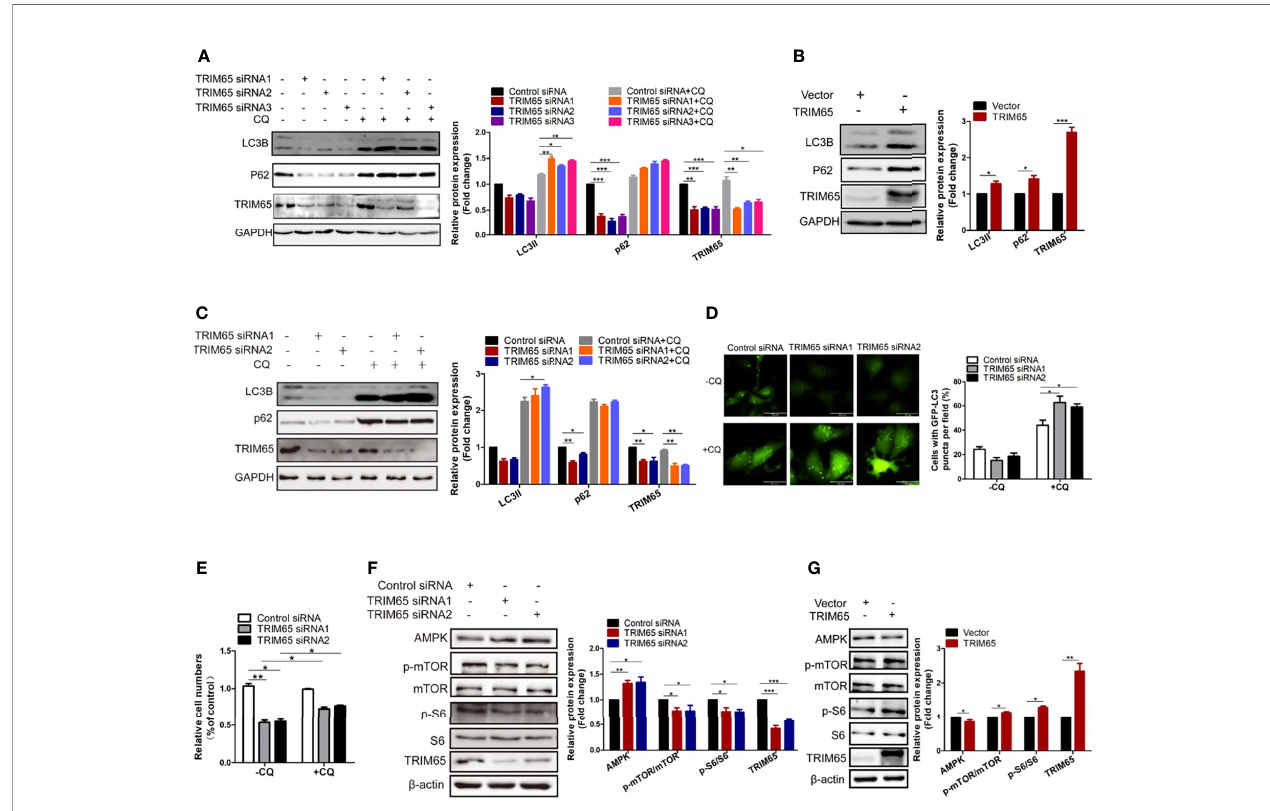
FIGURE 3 | Knocking down TRIM65 induces autophagy in cervical cancer. HeLa (A) and SiHa (C) cells with TRIM65 depletion were harvested and lysed for western blot analysis using LC3- and p62-speci fi c antibodies in the presence or absence of 20 m M CQ for 6 h. GAPDH was used as a loading control. Relative protein expression over GAPDH was quanti fi ed, and the statistical data was shown (Right panel). (B) HeLa cells were transfected with TRIM65 overexpression vector to determine the expression of LC3 and p62 by western blot analysis. Relative protein expression over GAPDH was quanti fi ed, and the statistical data was shown (Right panel) . (D) HeLa cells expressing GFP-LC3B were transiently transfected with TRIM65 siRNAs. 42 h later, the cells were treated with or without CQ for 6 hours and then analyzed by fl uorescence microscopy. GFP-LC3B puncta were counted under 40× magni fi cation. Scale bar = 20 m m. (E) HeLa cells were transfected with control siRNA or TRIM65 siRNA1, TRIM65 siRNA2. 24 h later, cells were seeded in 24-well plates in 0.5 mL complete culture medium treated with or without CQ. On the 4th day, cells were trypsinized and counted. The statistical data was shown. The autophagy related proteins were analyzed by western blot using indicated antibodies in cells with TRIM65 knockdown (F) and overexpression (G) . Relative protein expression over b -actin was quanti fi ed, and the statistical data was shown (Right panel). Data are presented as mean ± SD. The experiments were repeated three times independently and the data of one representative experiment was shown. *p < 0.05; **p < 0.01, ***p <